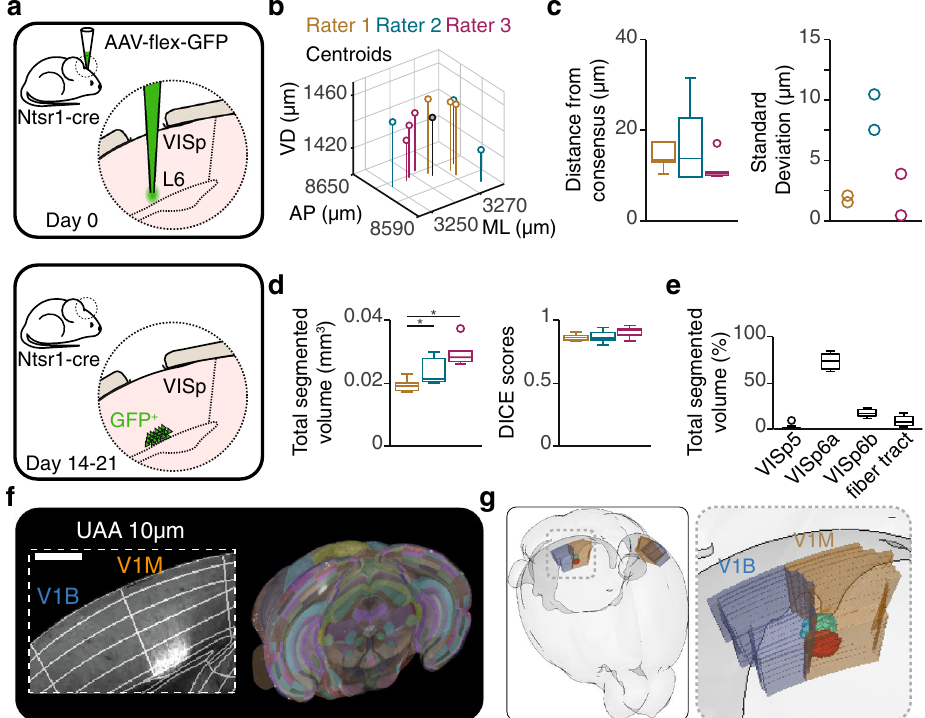
Figure 2. Segmentation of injection volumes using brainreg-segment. ( a ) Schematic of the injection segmentation experiment timeline. Top: Injection of an AAV carrying the fluorescent protein GFP in the primary visual cortex (VISp) of a Ntsr1-cre transgenic mouse at a depth of 900 μm (layer 6, L6). Bottom: Expression of GFP by a subset of cortical neurons (Ntsr1-positive cells). ( b ) Plot showing the 3D position of the segmented region centroids of each rater (open circles, n = 3 centroids per rater). The average centroid for all raters is also shown (grey circle). ( c ) Left: Box plot showing the distance from consensus for all centroids and for each rater. Right: Plot showing the standard deviation of each brain and for each rater. ( d ) Left: Box plot showing the total segmented volume for each rater. Right: Box plot showing the DICE scores for each rater. ( e ) Box plot showing the percentage of segmented volume in each CCFv3 brain region. ( f ) Left: coronal image of the primary visual cortex (inset) and projection of the first 850 brain images (green channel) acquired with serial two-photon tomography, overlaid with the UAA atlas. Scale bar = 500 μm. ( g ) Rendering of the segmented regions within the primary visual